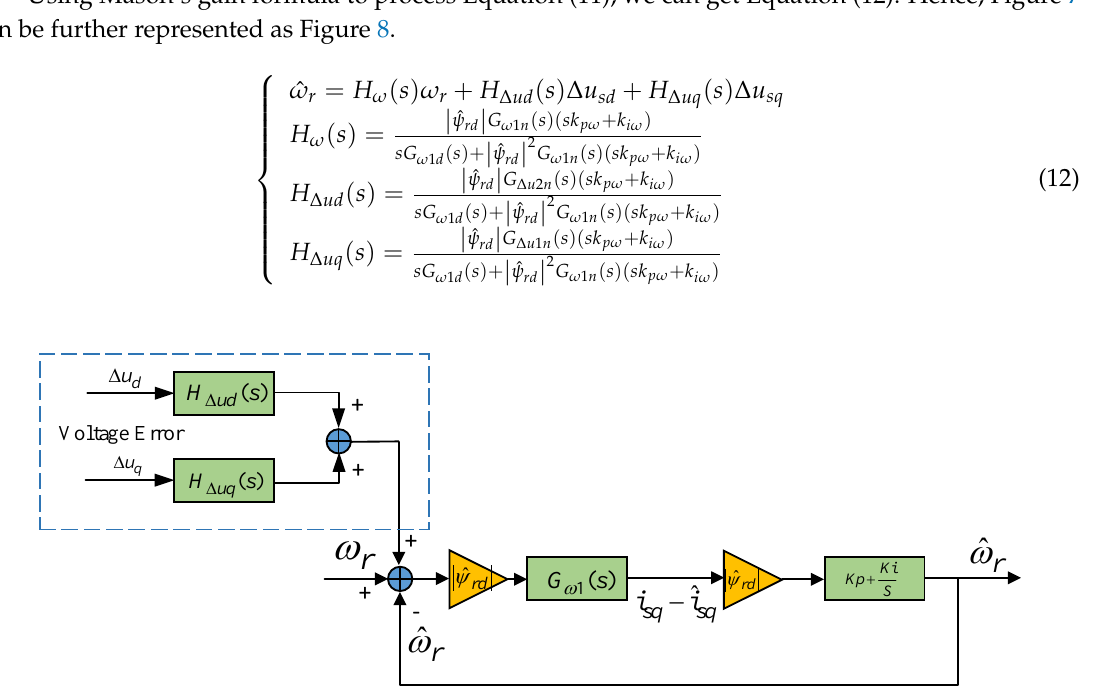
Table 1. Parameters of the induction motor.